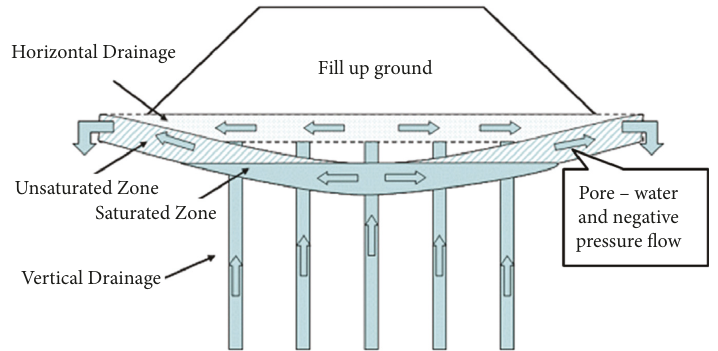
Figure 1: Combined vertical and horizontal soft ground drainage Table 1: Specific gravity, grain size distribution, and USCS designation for crushed stone aggregate and sand. Material